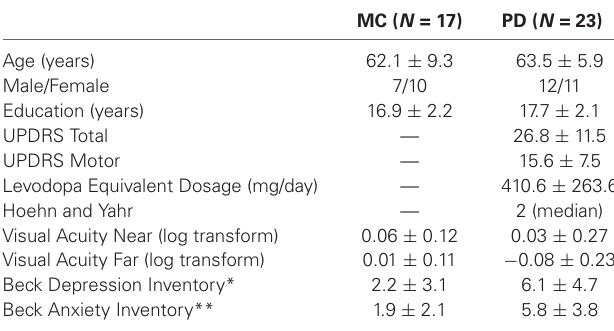
Table 1 | Participant demographics, perceptual screening, and mood assessment